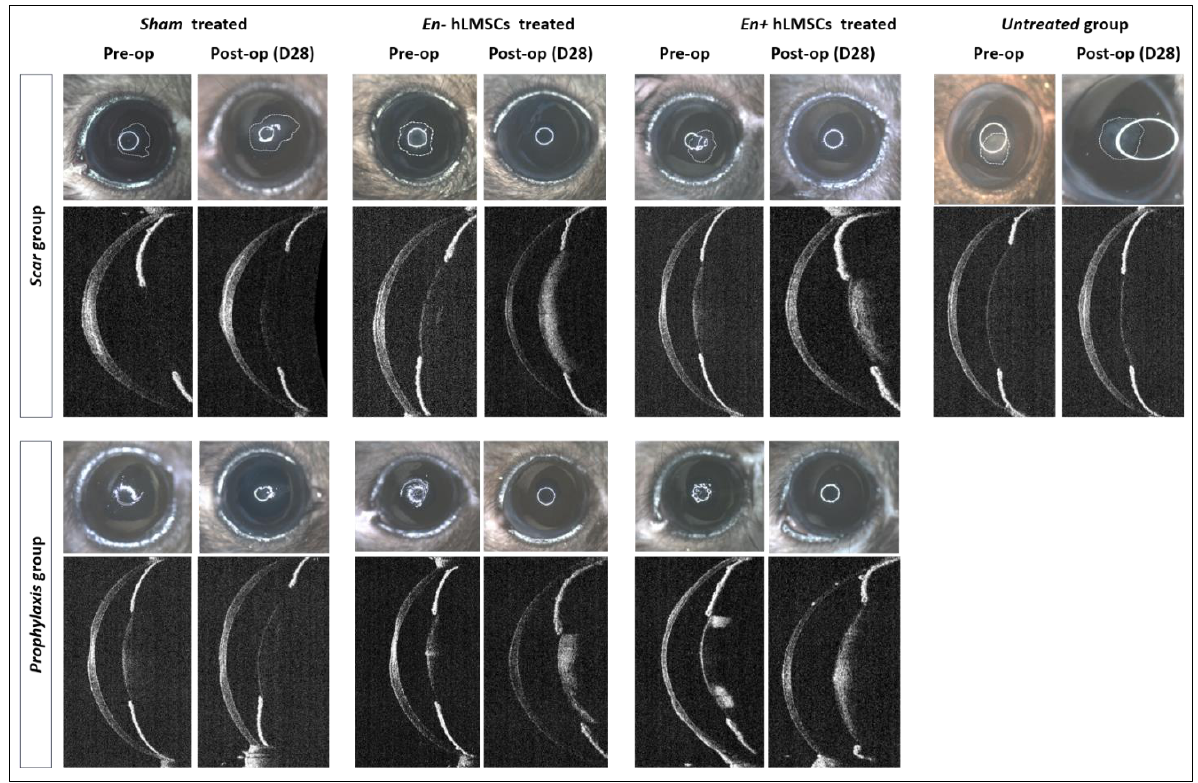
Figure 4. Outcomes of the treatment with hLMSCs: Collage of representative microphotographs and scans showing the scarring of debrided corneas before and after treatment with hLMSCs. Eyes of the untreated and sham treated arms show the unhealed corneas post debridement/treatment. Eyes treated with En− /En+ hLMSCs showed relatively clear corneas with less haze and scarring.